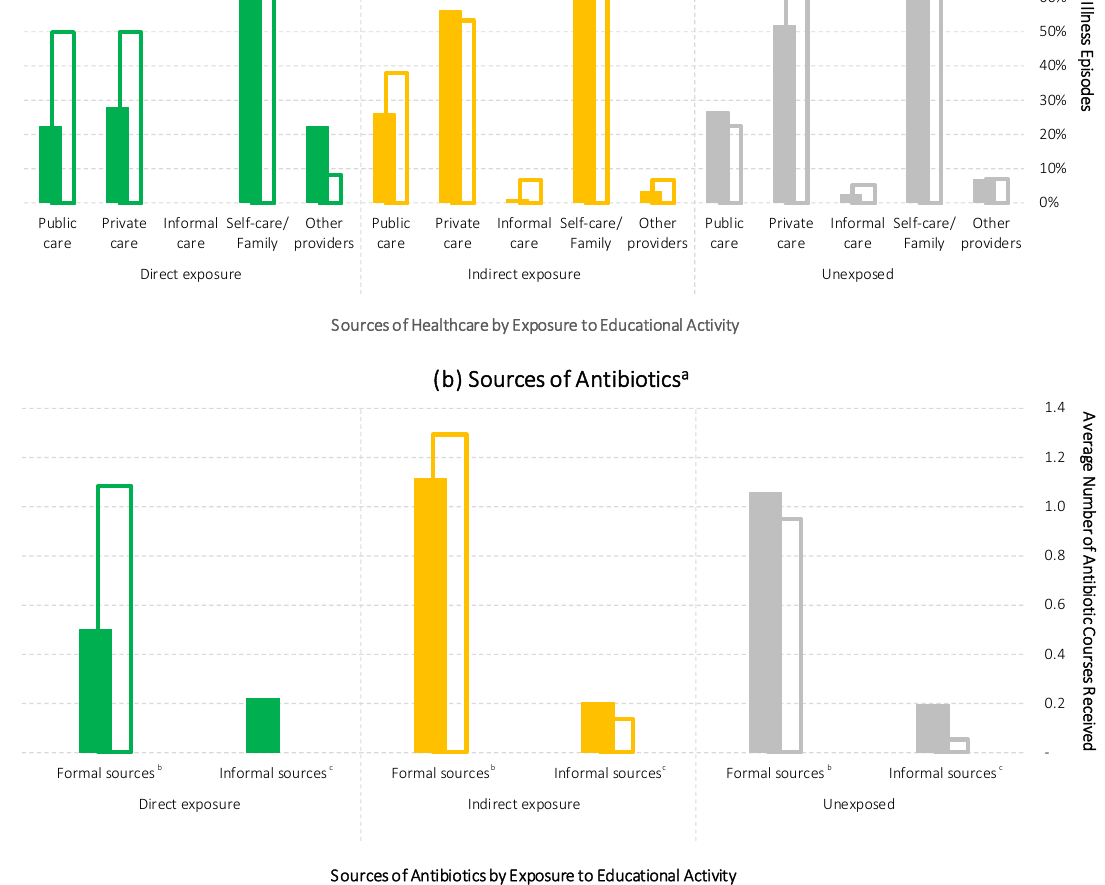
Figure 4. Healthcare access and sources of antibiotics across survey rounds. Panel ( a ) Patterns of healthcare access by activity participation. Panel ( b ) Sources of antibiotics across survey rounds.